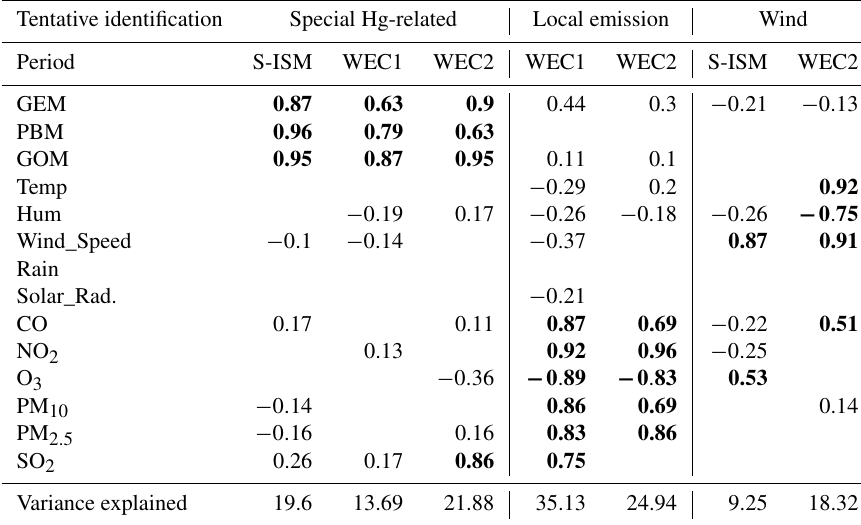
Table 4. PCA factor loadings (varimax-rotated factor matrix) for Hg in Lhasa, China.